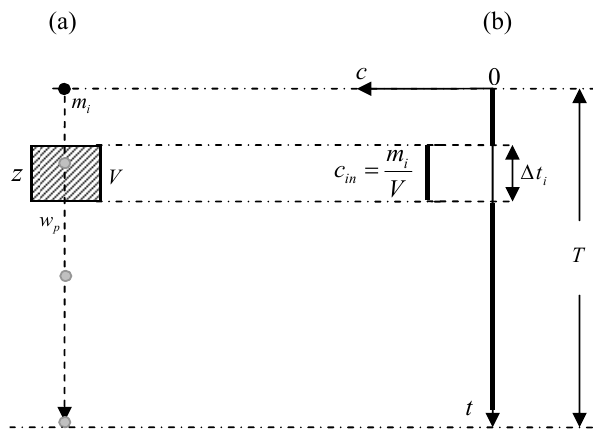
Figure 6. Illustration of one particle’s contribution to dust con- centration. (a) A dust particle (dot) passes through the sampling area (shaded); (b) Dust concentration corresponding to the situation shown in (a).